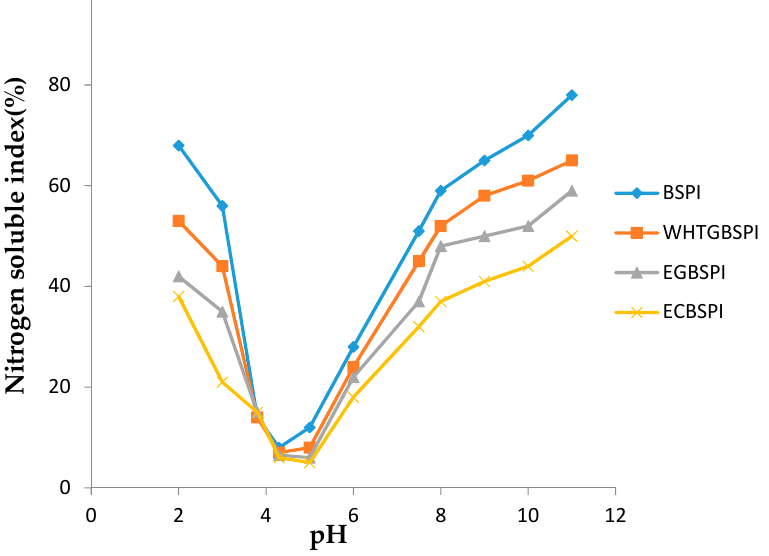
Figure 7. Solubility-pH profiles of BSPI and its modified products in pH range of 2~11. Data are shown as the mean ± SD of three replicates.